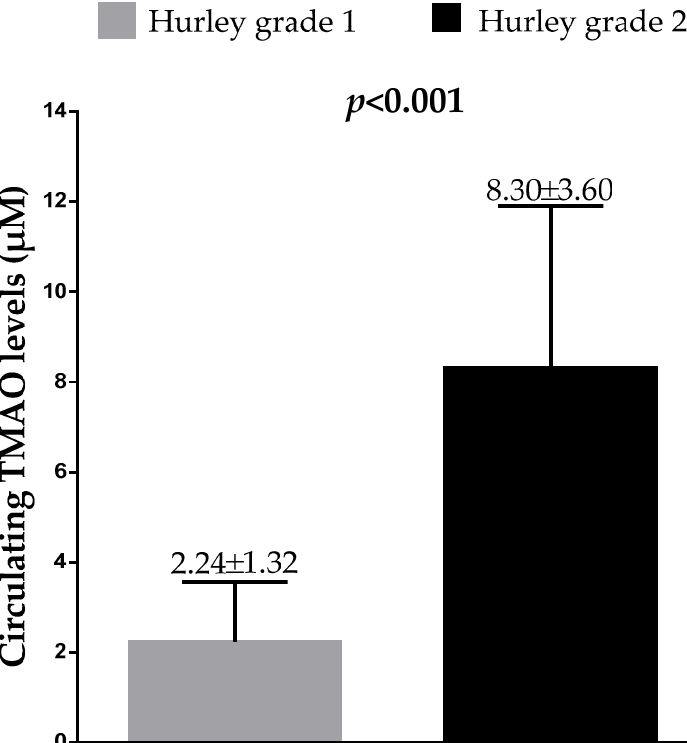
Figure 2. Difference in circulating TMAO levels in HS patients between Hurley grade 1 vs. Hurley grade 2. Difference was analyzed by Student’s impaired t -test. Results were expressed as mean ± SD. A p value in bold type denotes a significant difference ( p < 0.05). TMAO, trimethylamine n- oxide.